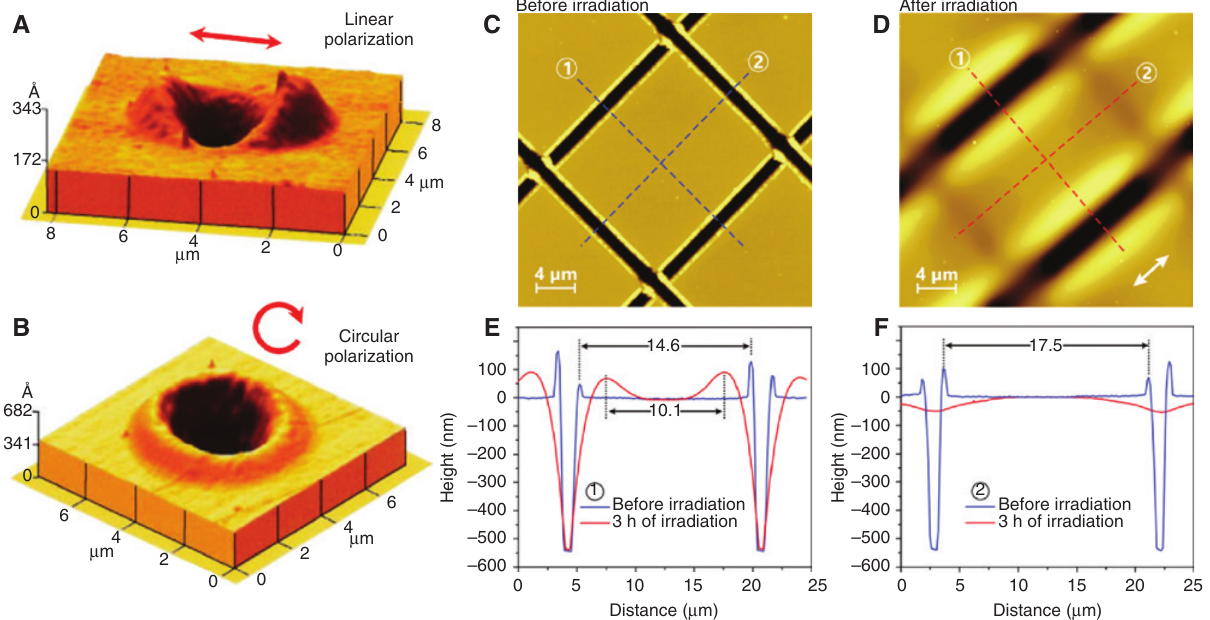
Figure 3: Polarization-dependent directional mass transport in azopolymers. Surface reliefs resulting from linearly (A) and circularly (B) focused Gaussian beams. (A–B) Adapted from Ref. [101] with permission from AIP Publishing. (C–F) Polarization-dependent selective filling of scratches practiced in orthogonal directions over an azopolymer surface. Reproduced from Ref. [102] with permission from the Royal Society of